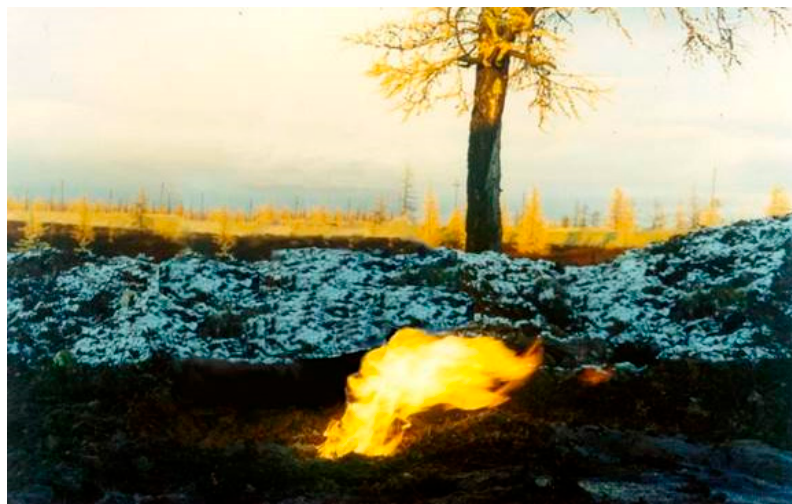
Figure 7. Burning of intrapermafrost gas rising from a depth of 15 m at the head of a geotechnical borehole (Zapolyarny field). Photograph by people from Fundamentproekt Company (number on the map: 13) [89]. Table 2. Gas components and δ 13 C (in methane) in gryphons around boreholes, Zapolyarny field [89]. Borehole